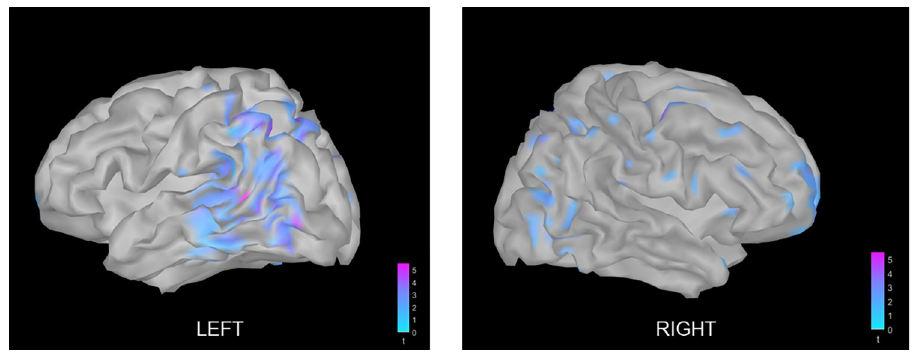
Fig 6. Results of paired permutation test (objects vs meaningless objects) performed on alpha power spectrum of sources and projected on a template anatomy cortex.